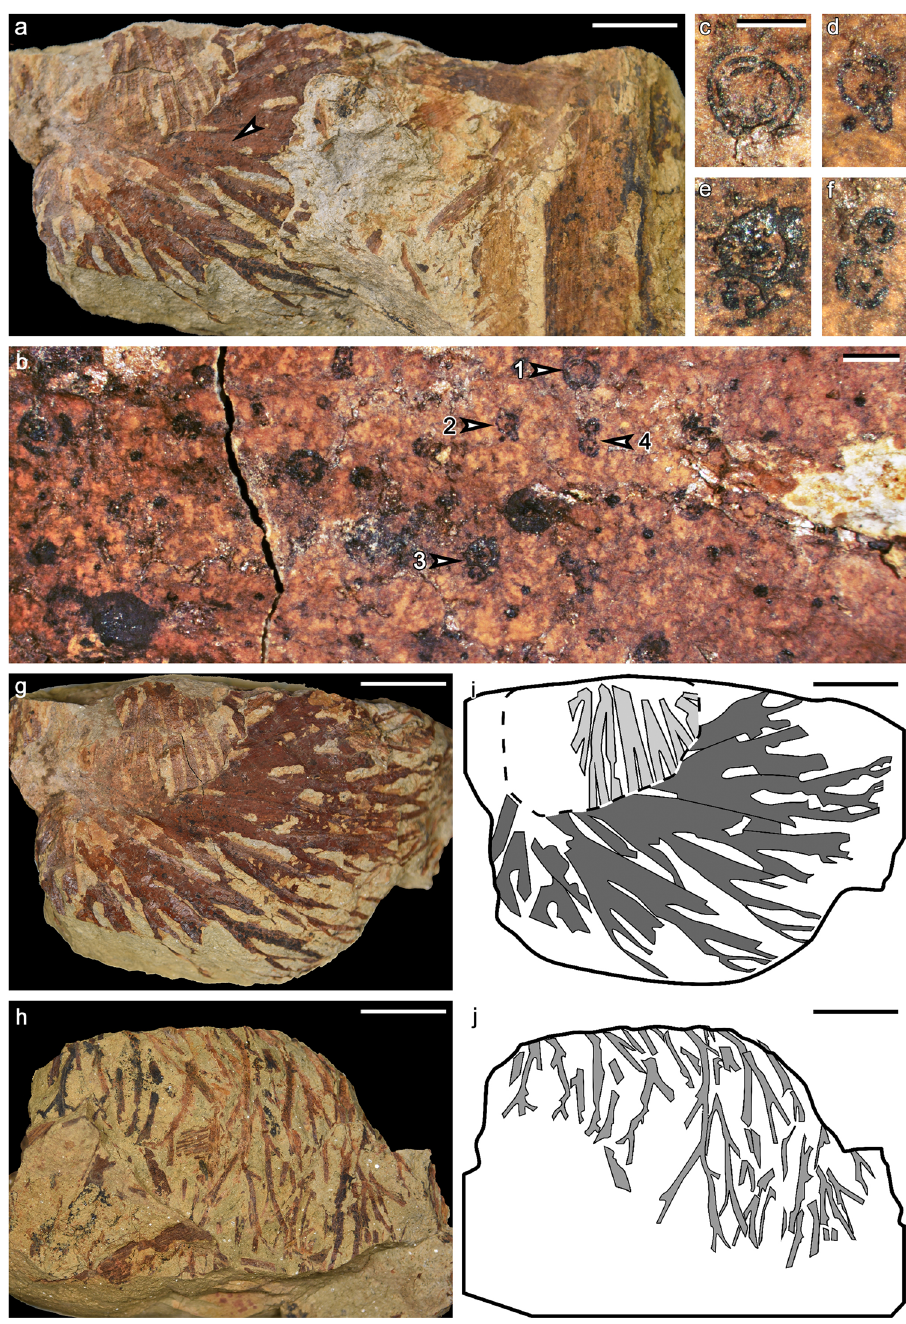
Fig. 5 Associated roots of Omprelostrobus gigas gen. et sp. nov. Scale bars: a, g – j: 2 cm; b, 1 mm; c – f, 0.5 mm. a Dichotomized roots radially arranged in two directions, associated with a lycopsid axis. Arrow indicating portion enlarged in b . PKUB19311. b Enlargement of a (arrow), showing the arrangement of circular structures. Arrow 1 – 4 indicating circular structures enlarged in c – f , respectively. c – f Enlargement of b (arrow 1 – 4), respectively, showing details of the circular structures. g Roots shown in a , after dégagement, showing multiple dichotomies. h The other side of specimen shown in g , showing more slenderer roots with multiple dichotomies. i , j Interpretative line drawings of the roots shown in g , h , respectively. Grayscale indicates roots in different